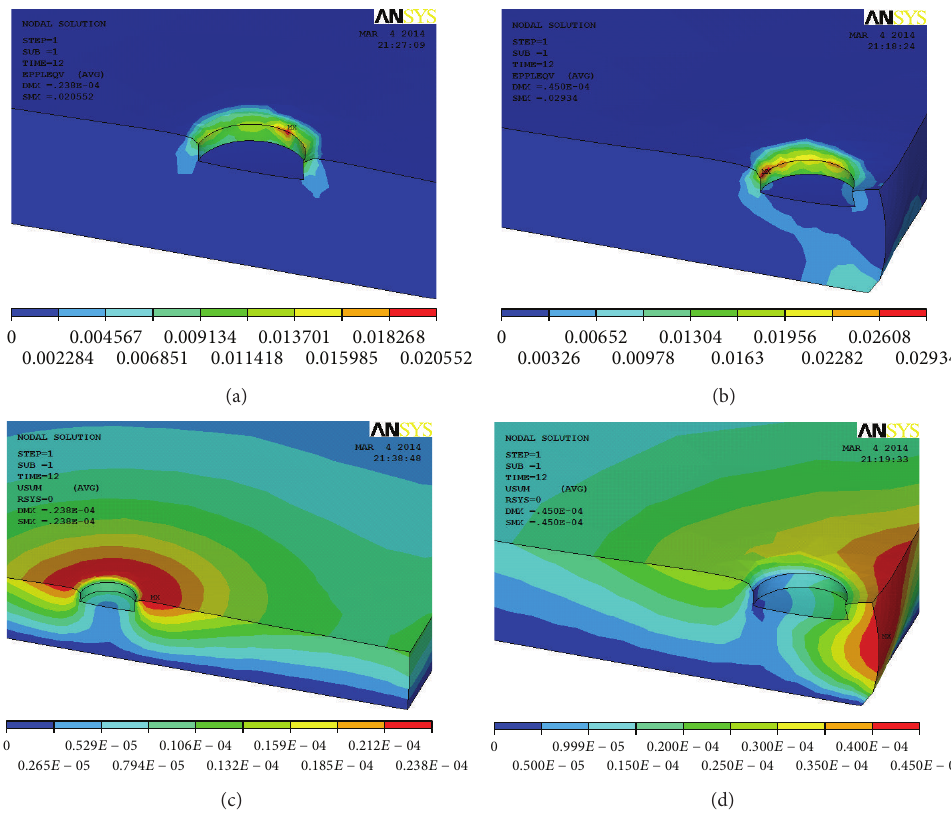
Figure 12: FEM results. (a) and (b): plastic strain and (c) and (d): material displacement, for 𝑥 1 = 30 and 5 mm, respectively, at the time = 12s of the plunging stage.